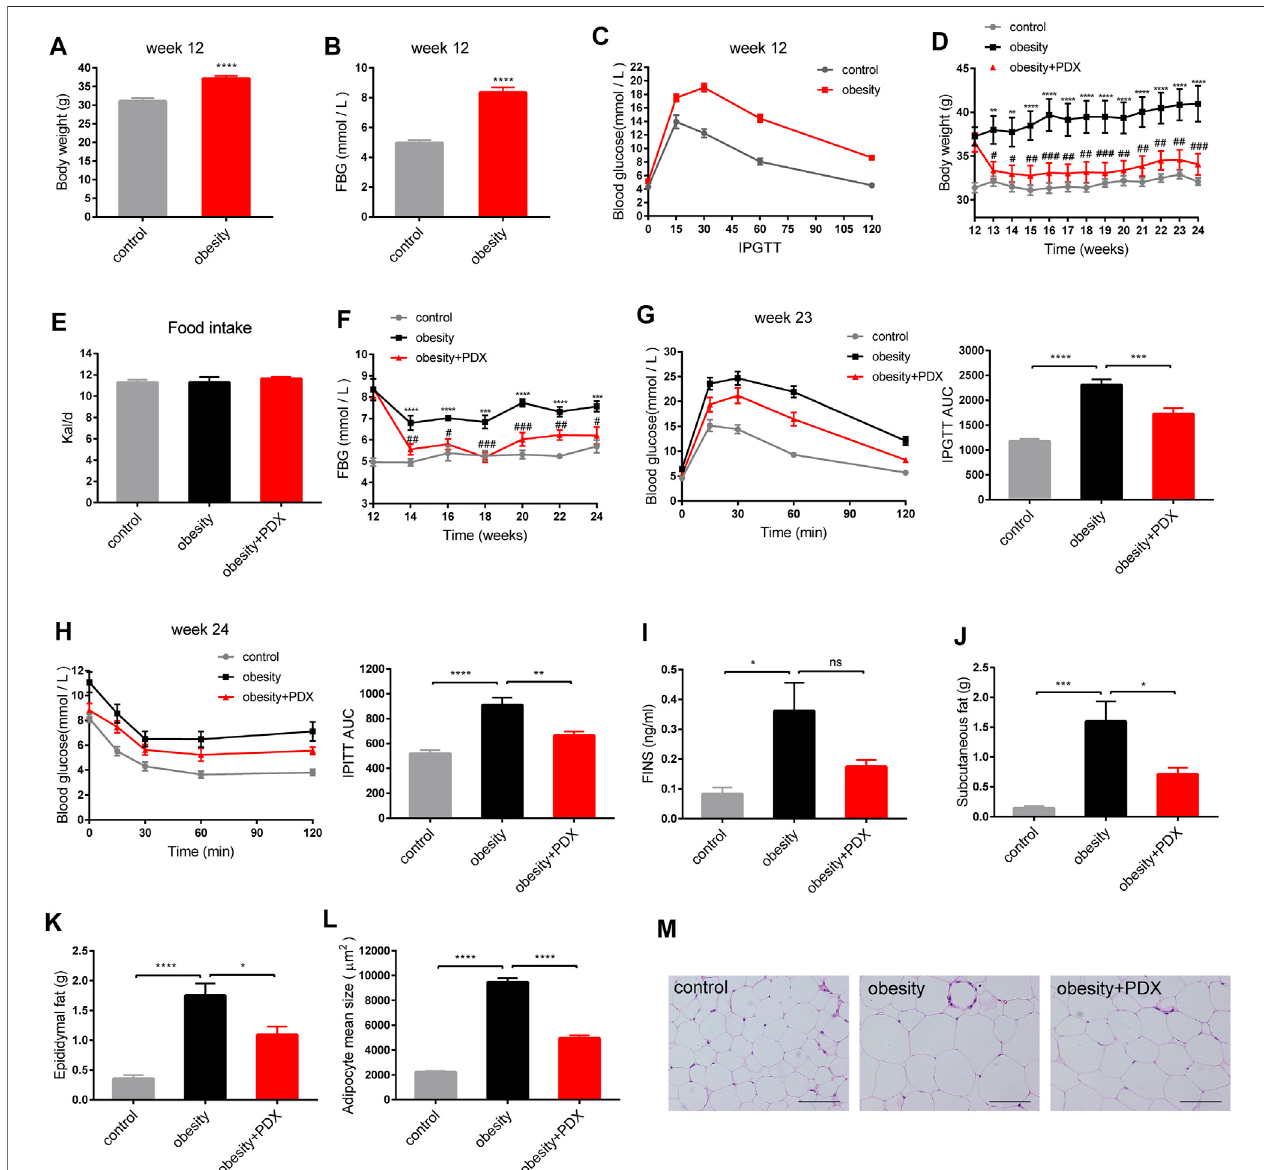
FIGURE 5 | PDX alleviated obesity-related traits in HFD-induced obese mice (Part 2). (A – C) C57BL/6 mice were fed a HFD for 12 weeks to establish an obesity model. (A) Bodyweightat week12. (B) FBGat week12. (C) IPGTT atweek12. (D – M) TheHFD-inducedobesemicewerethentreatedwithPDXforanother12 weeks. (D) Body weight. (E) Food intake measured as kilocalories per day. (F) FBG. (G) IPGTT and AUC measured during the IPGTT at week 23 (mM · min). (H) IPITT and AUC measured during the IPITT at week 24 (mM · min). (I) FINS. (J) Subcutaneous fat accumulation. (K) Epididymal fat accumulation. (L) Adipocyte mean size. (M) RepresentativeimagesofH&E-stained epididymal adiposetissues.Scalebar,100 μ m;magni fi cation,x200. n (cid:2) 10per group.* p < 0.05;** p < 0.01;*** p < 0.001;**** p < 0.0001; ns, not statistically signi fi